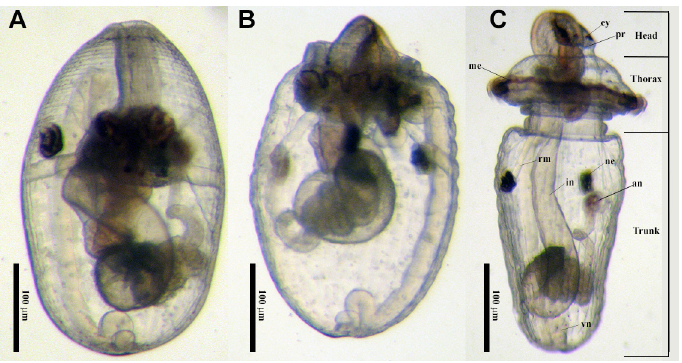
Figure 5. Pelagosphera larvae from Sipunculus sp. ( A ) Pelagosphera larva with the head and thorax retracted inside the trunk; ( B ) Pelagosphera lateral view of a larva in the process of extending the head from the trunk; ( C ) Dorsal view of the pelagosphera larva showing regions of the body and external and internal structures viewed through the translucent the body wall. Abbreviations: an = anus, ey = eye, in = intestine, me = metatroch, ne = nephridia, pr = prototroch, rm = retractor muscle, vn = ventral nerve